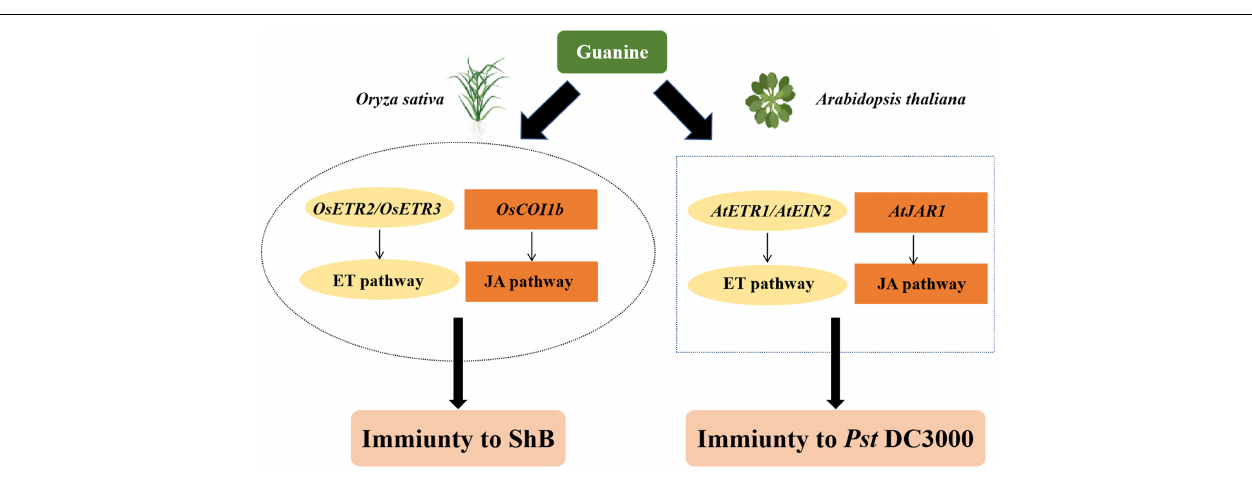
FIGURE 7 | A proposed model of guanine-mediated plant immunity. In rice, OsETR2 , OsETR 3, and OsCOI1b are required for guanine-induced plant immunity to ShB. Similarly, guanine also needs AtETR1 , AtEIN2 , and AtJAR1 to enhance plant resistance to pst DC3000 in